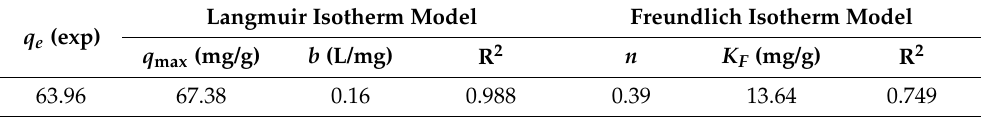
Table 4. Characteristic parameters obtained by the Langmuir and Freundlich isotherm models. Langmuir Isotherm q e (exp)